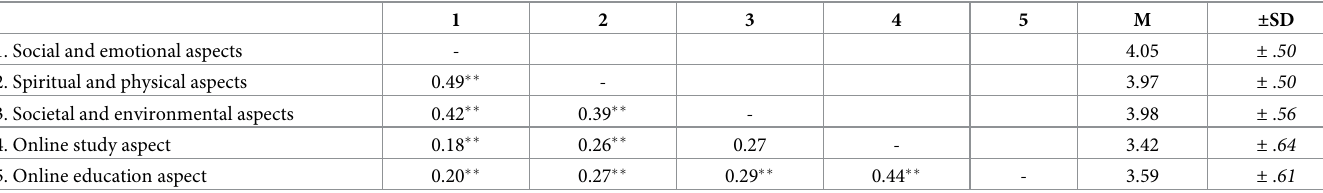
Table 9. Pearson correlations among aspects of students’